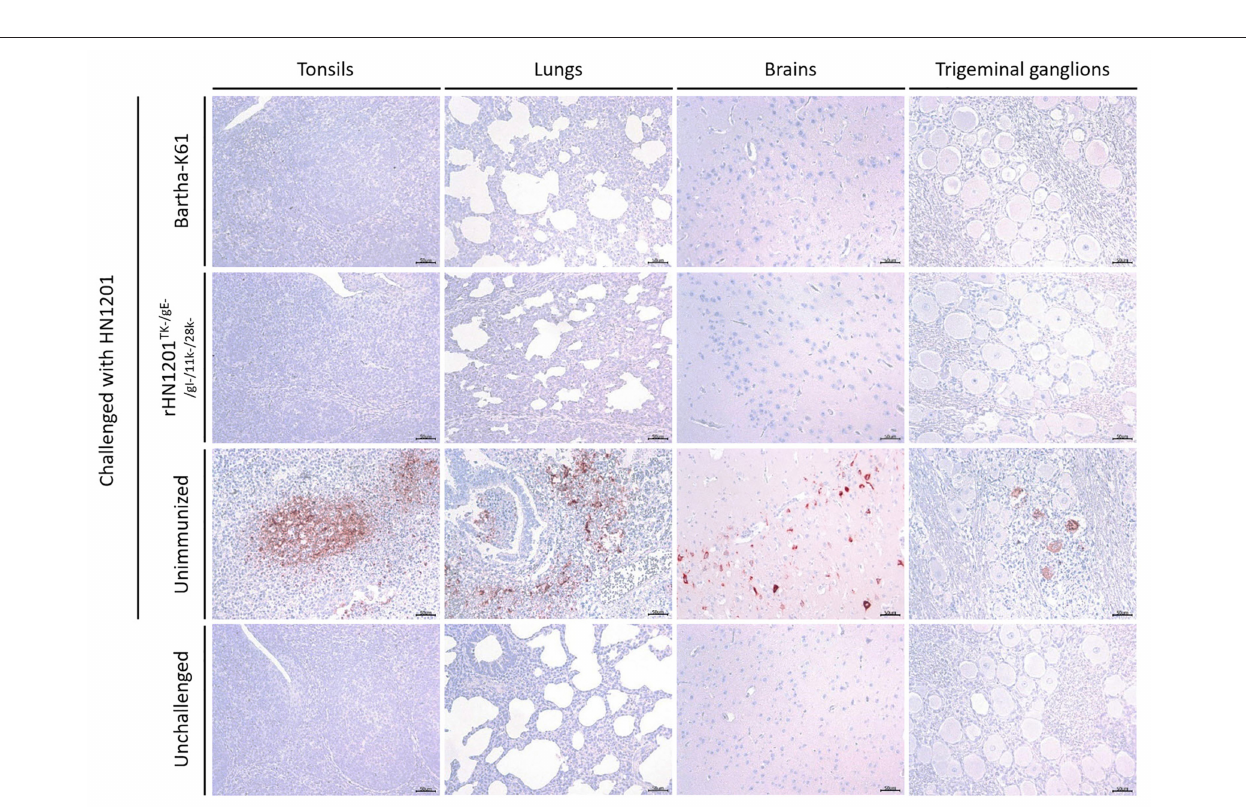
FIGURE 4 | Production of PRV-specific antibodies after vaccination and viral load test of pigs after challenge. (A) The gB antibodies were detected at the indicated time points after vaccination. The ELISA values of pig serum samples are given as S/P ratios, S/P > 0.5 was considered positive. (B) NAbs against the HN1201 and Bartha-K61 in the indicated groups at 21 dpv and 35 dpv (14 dpc). Standard deviations are shown as error bars. The t -test was performed for statistical analysis. (C) Viral load detection of pigs after challenge with HN1201. The viral loads between different groups were analyzed by t -test. Asterisk denotes a statistically significant difference ( P < 0.05), ns indicated no significant difference.